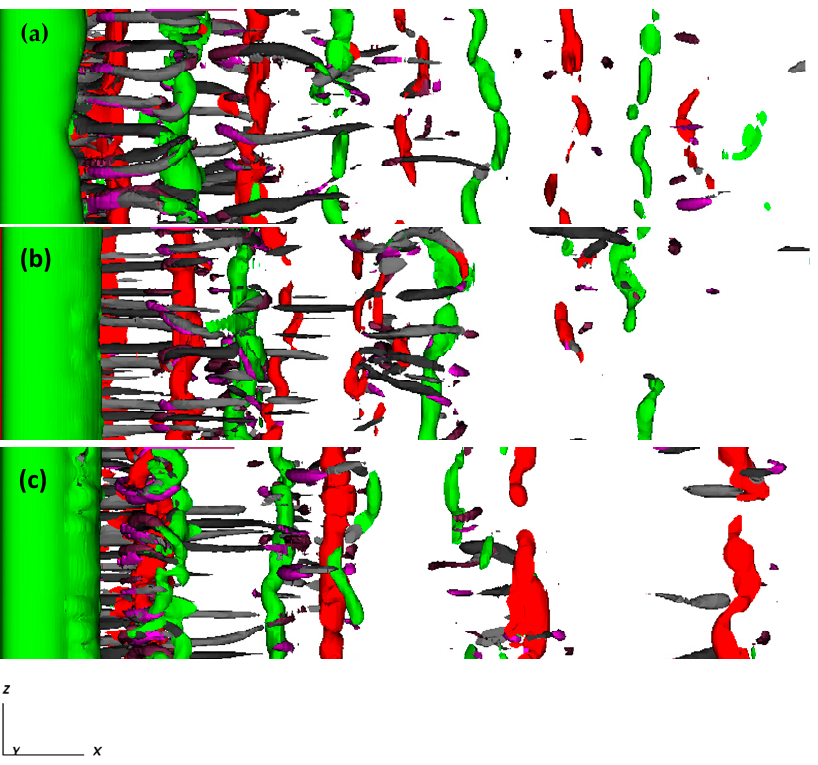
Figure 22. Clockwise cylinder oscillation: Instantaneous vorticity isosurfaces (top view) for F = 0.8 and (a) A y /D = 0.10, (b),